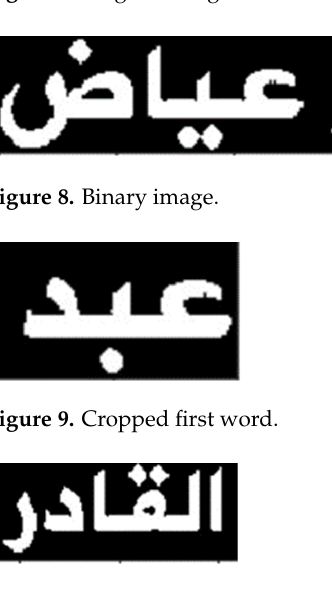
Figure 10. Cropped second word.